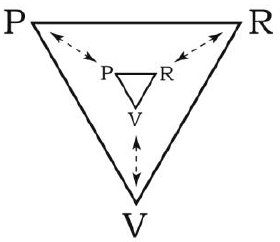
Figure 11: The Transference